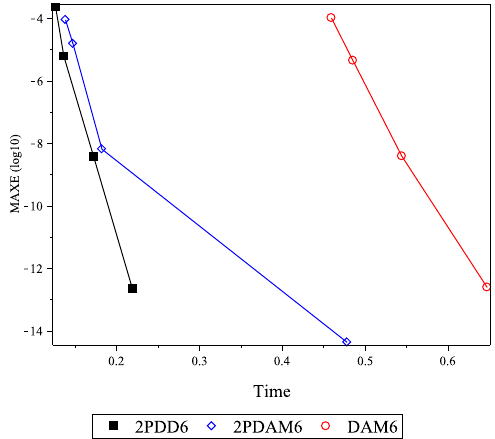
Figure 4. Performance graphs of time vs. log MAXE for Problem 1.